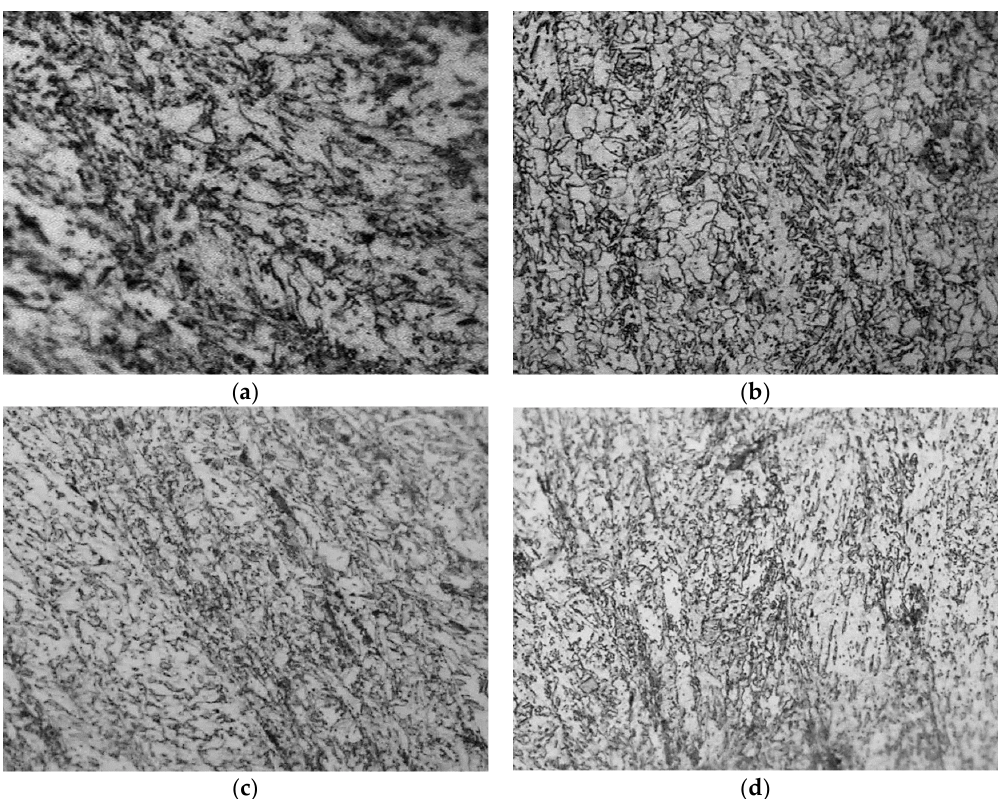
Figure 6. Metallurgical structures under asbestos coverage, 500x: ( a ) S1; ( b ) S2; ( c ) S3; ( d ) S4.